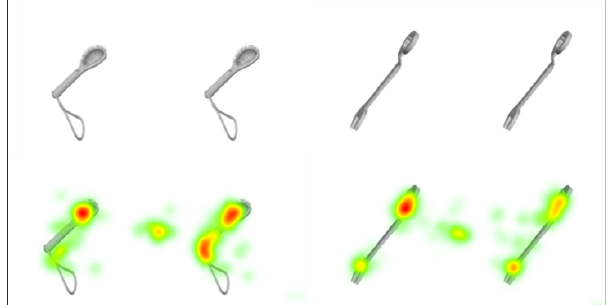
Figure 2: Brush and wrench at 0° angle above; below the corresponding heat